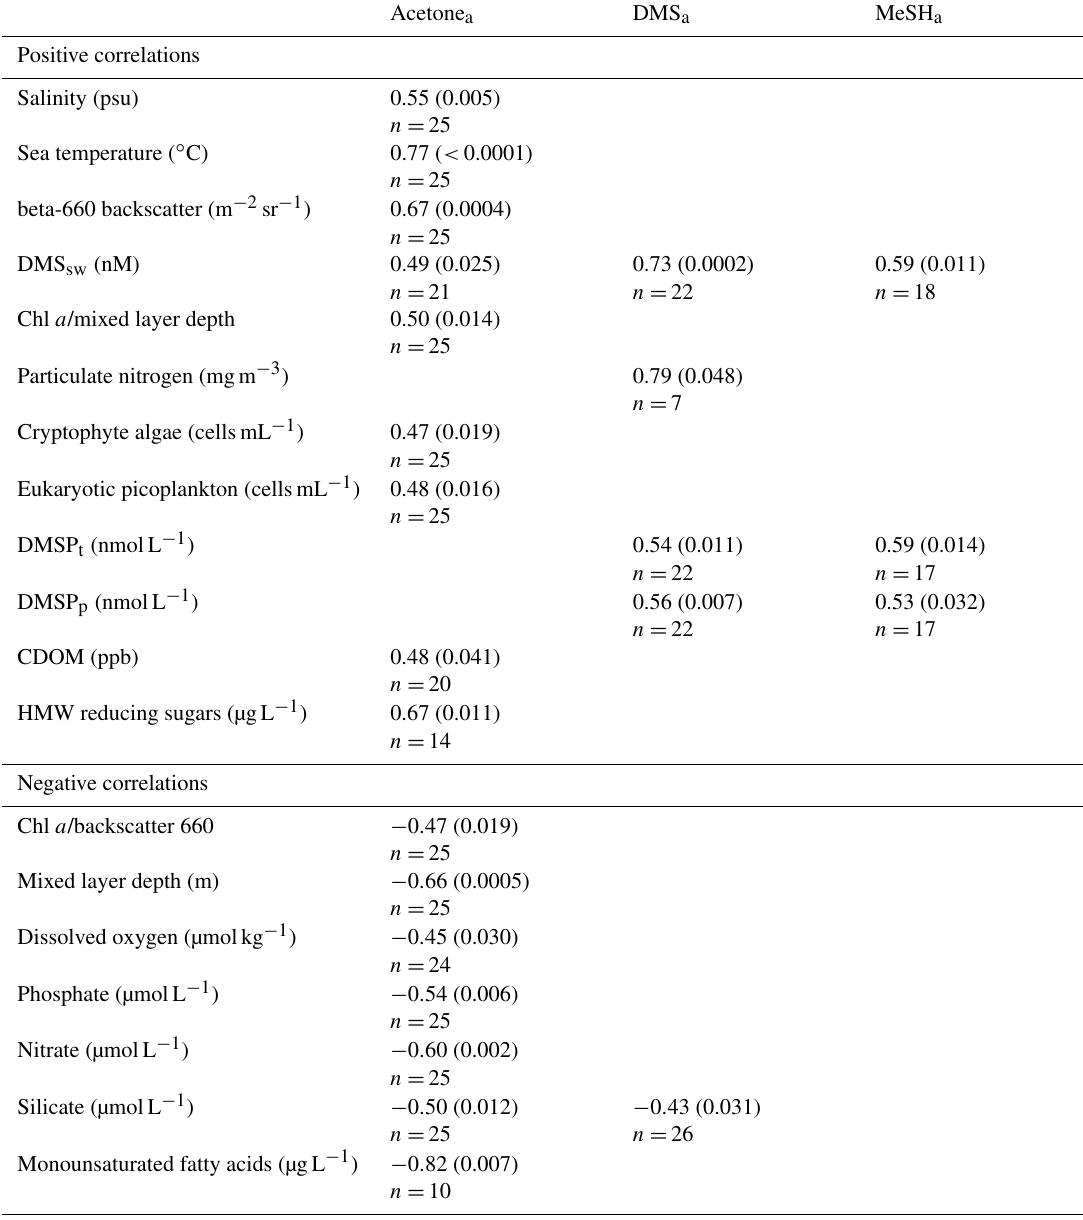
Table 6. Spearman rank correlations between acetone a , DMS a and MeSH a , as well as biogeochemical parameters, using data from the 14 February–4 March 2012 (acetone a , DMS a ) and 20 February–4 March 2012 (MeSH a ). Correlations shown are significant at the 95% confidence interval (CI). Correlation coefficient (and p value) are shown. No entry indicates there was no correlation at 95% CI. Land- influenced acetone a data excluded (see text for